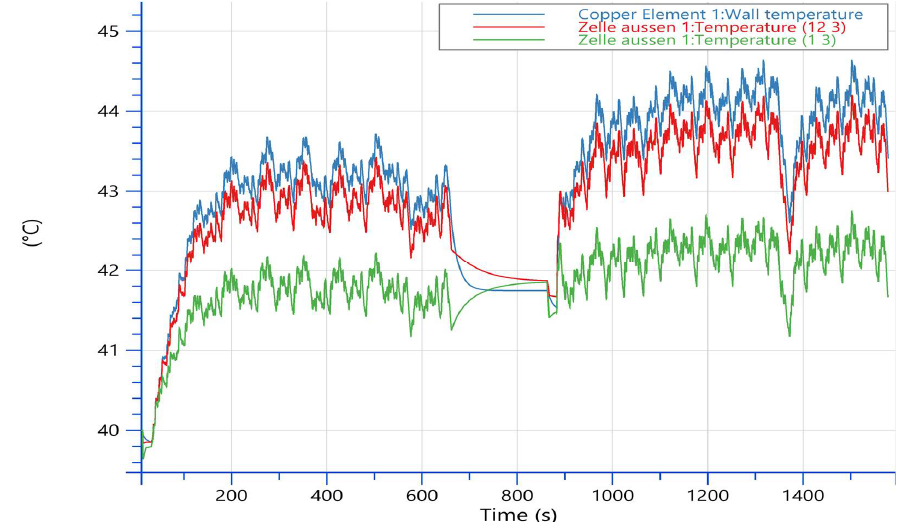
Figure 8. Thermal behavior of the battery cells and connecting terminals.